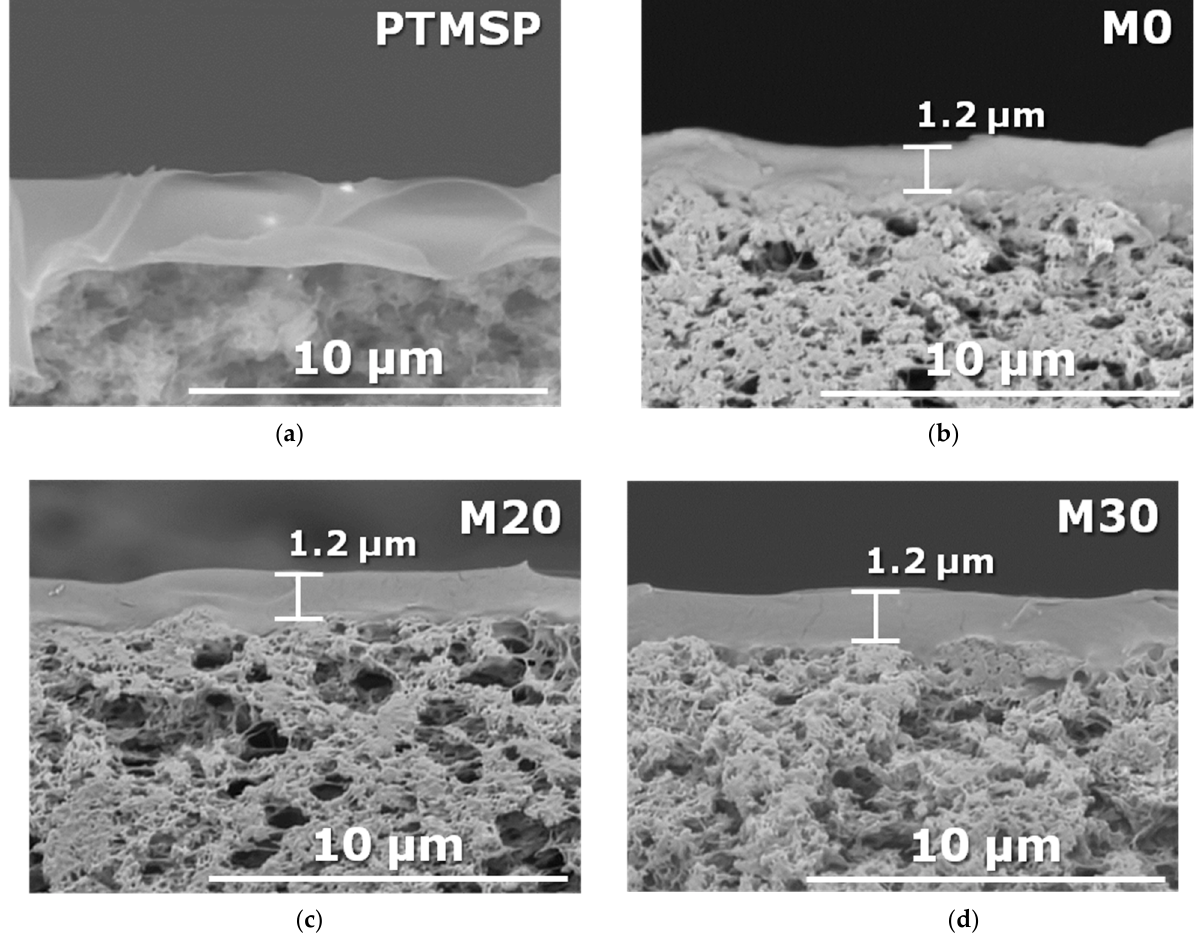
Figure 3 . SEM images of the cross-section of TFC membranes after 60 s exposition in chloroform: ( a ) a neat PTMSP, ( b ) M0, ( c ) M20, and ( d ) M30 cross-section. ( a ) a neat PTMSP, ( b ) M0, ( c ) M20, and ( d ) M30